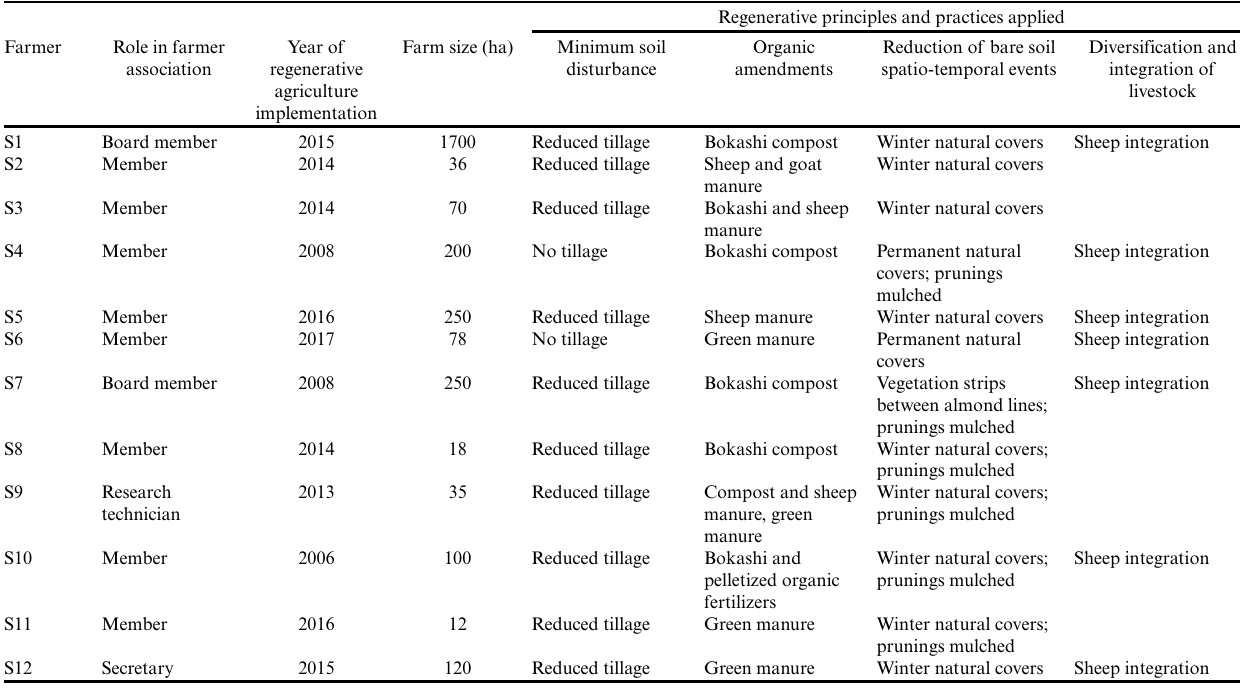
Table 1. Description of participating farmers and farms according to the main regenerative agriculture principles and practices implemented in the parcels selected for participatory monitoring and evaluation.